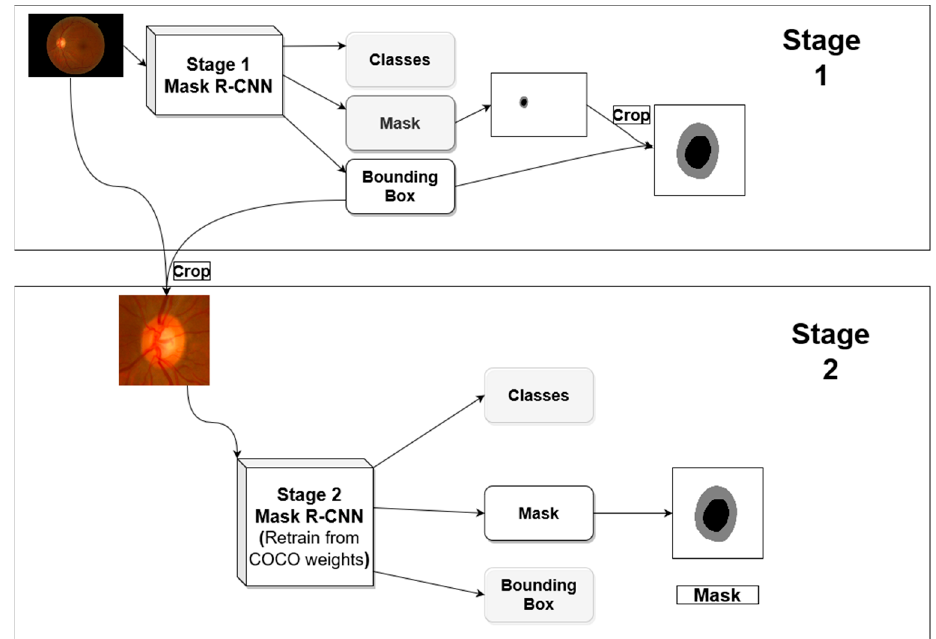
Figure 2. Overall segmentation process. In stage 1 (top box) the network produces classification, masks and bounding boxes. We only use the bounding box information to crop the input images (during the training the ground truth bounding box is also cropped). In the second stage (bottom box) the cropped image (based on bounding box from stage 1) is put through the second stage network producing classification, masks, and bounding boxes. The masks output is used for vertical cup-to-disc ratio (vCDR) calculation and segmentation evaluation .